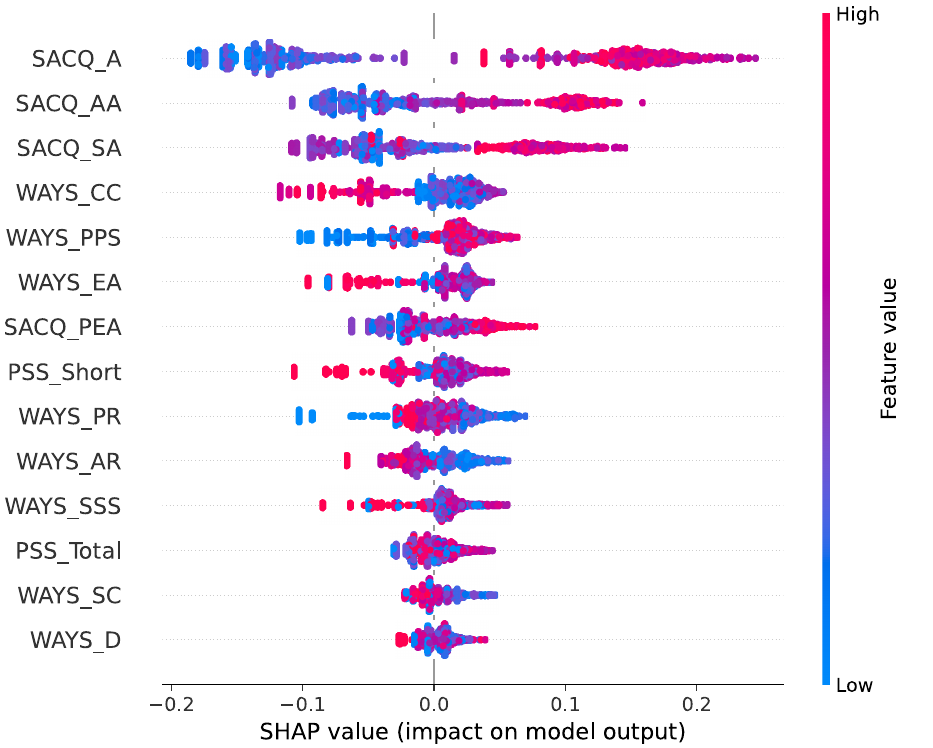
Fig 4. SHAP plot for social support adjustment using the random forest